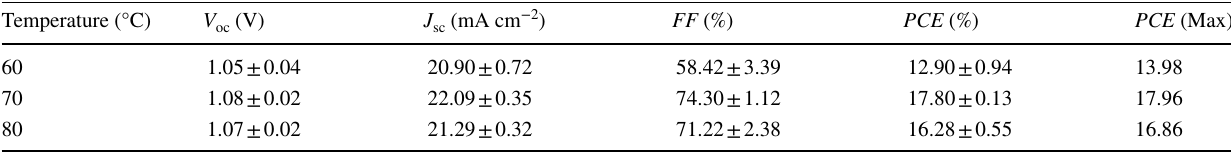
Table 1 Average values of photovoltaic parameters obtained from J–V measurements for PSCs derived from PbI 2 :CsI prepared by slot-die coat- ing under ambient conditions at the different bed temperature